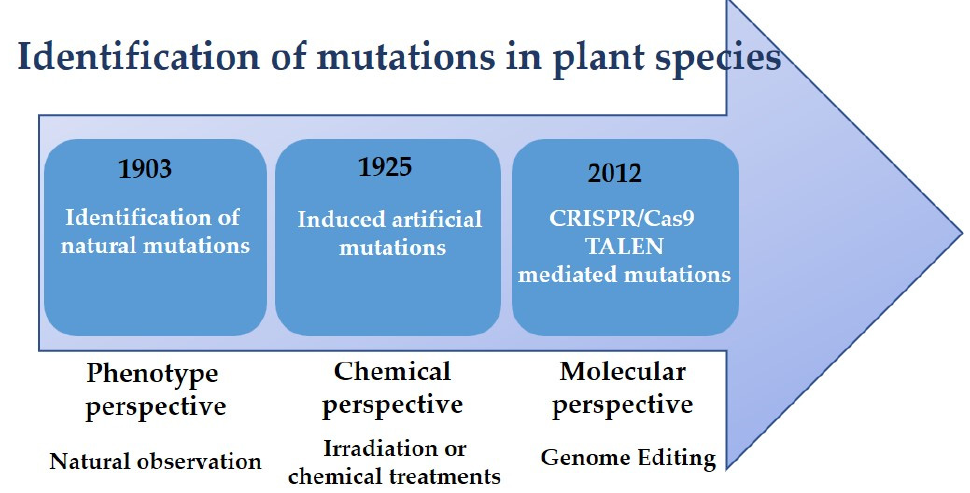
Figure 1. Historical perspective of the identification of mutations in plant species.